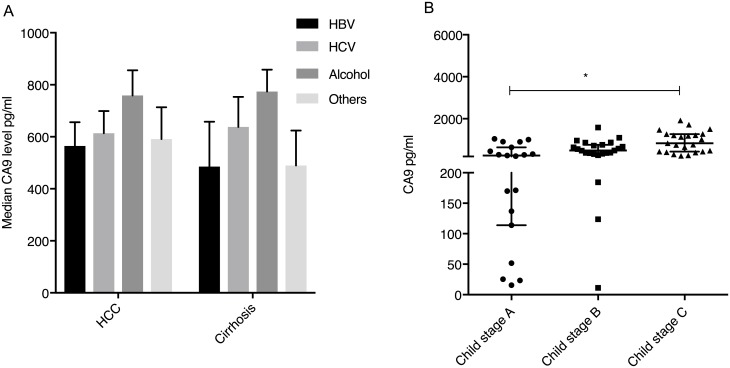
CA9 levels in patients with cirrhosis only and etiology of HCC.A Median CA9 levels according to etiology of liver disease in patients with HCC compared to patients with cirrhosis only. (*, P<0.01). A CA9 levels in different stages of Child Pugh in cirrhotic patients. Vertical lines indicate the range, the horizontal boundaries of the boxes represent the first and third quartile.